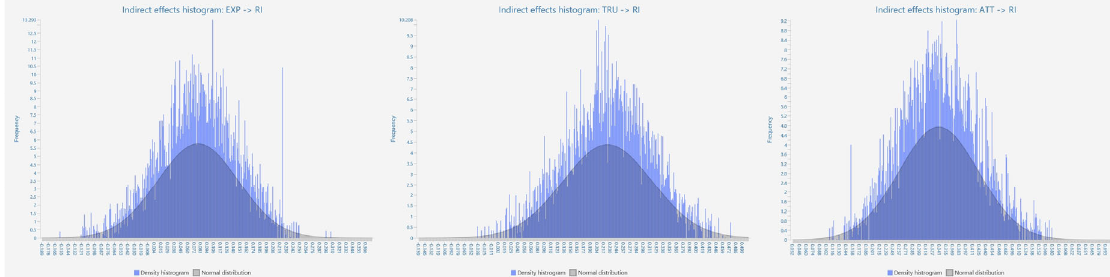
Fig. 5. Histogram of the